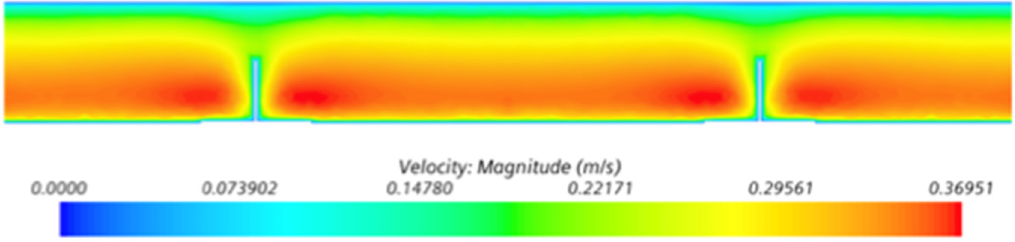
Figure 13. Velocity field—horizontal cross section at height of 10 m summer extreme.